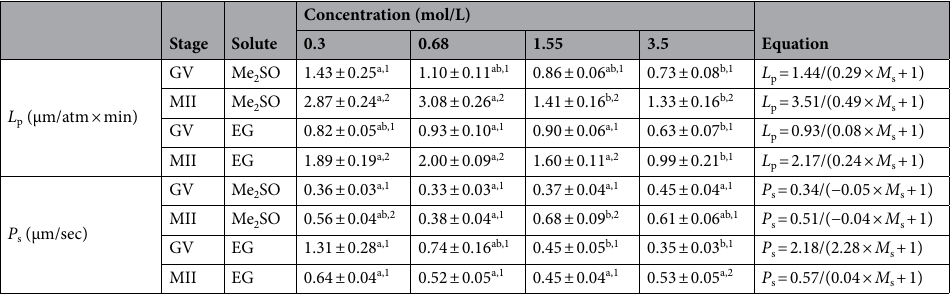
Table 1. Bovine oocyte plasma membrane water permeability ( L p ), solute permeability ( P s ) of immature (GV) and mature (MII) oocytes in the presence of increasing CPA (EG or Me 2 SO) concentrations. Permeability parameters obtained from 0.3, 0.68, 1.55 and 3.5 mol/L EG or Me 2 SO data fit with the 2P model. The equation represents the best-fit model curve for each stage and CPA using the concentration dependent model described above. Unless indicated otherwise, data are given as the mean ± s.e.m. Different superscript letters indicate significant differences between different molarities within the same CPA and nuclear stage ( P < 0.05). Different superscript numbers indicate significant differences in water or solute permeability between GV and MII stage within the same CPA ( P < 0.05). GV germinal vesicle, MII metaphase II, Me 2 SO dimethyl sulfoxide, EG ethylene